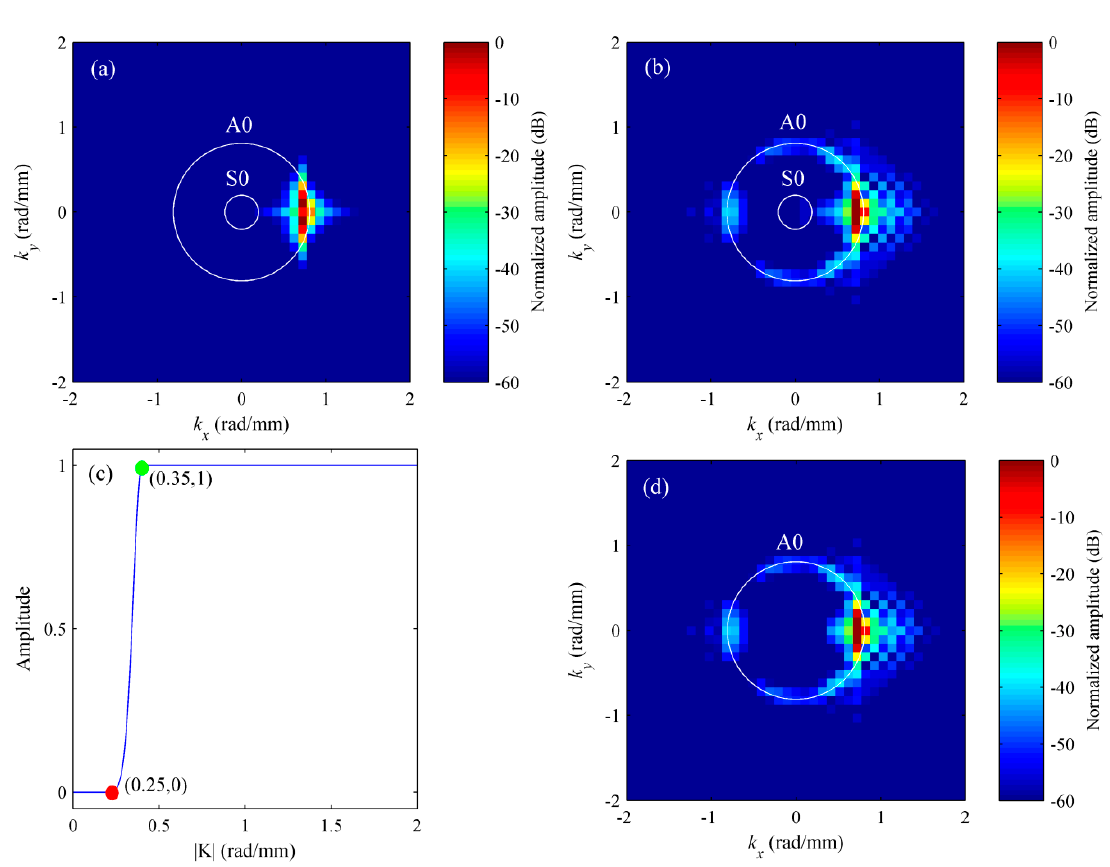
Figure 7. Mode separation based on the spatial ‐ wavenumber filtering technique. ( a ) Wavenumber spectrum for the pristine plate; ( b ) wavenumber spectrum for the damaged plate; ( c ) high ‐ pass filter in the wavenumber domain; ( d ) filtered wavenumber spectrum. White circles are theoretical wavenumber curves for the S0 and A0 modes.